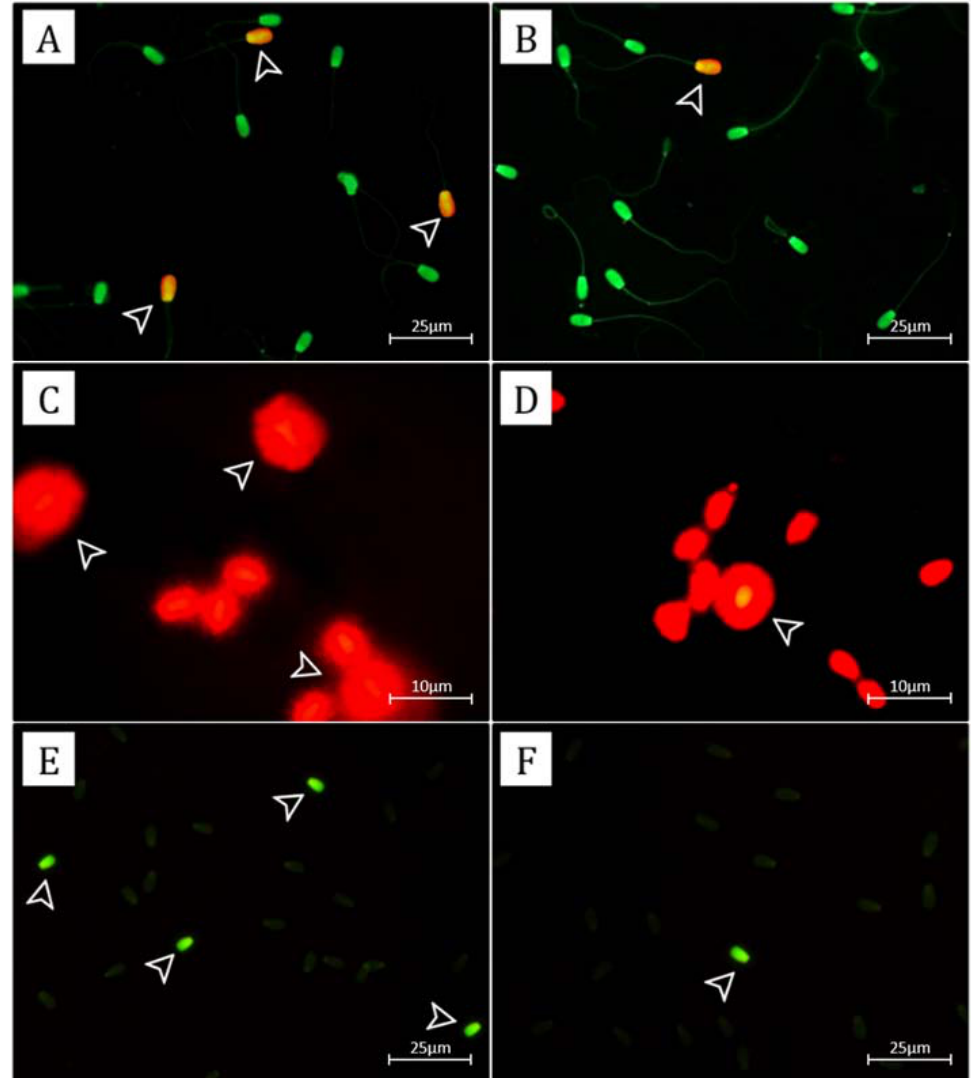
Figure 1. The photomicrograph of sperm in AO staining of HF and LF bulls ( A , B ); Sperm with normal DNA integrity will be stained with green fluorescence; SDF will be stained with yellow- orange fluorescence (arrow). The photomicrograph of Halomax test in HF and LF bulls ( C , D ); Sperm with normal DNA integrity showed a slight halo, and SDF showed a large halo (arrow). The photomicrograph of PRM deficiency by the Chromomycin A3 (CMA 3 ) assay ( E , F ); bright green fluorescence-stained sperm (CMA3+) indicated PRM deficiency (arrow), whereas dull green-stained sperm (CMA3 − ) indicated normal PRM.